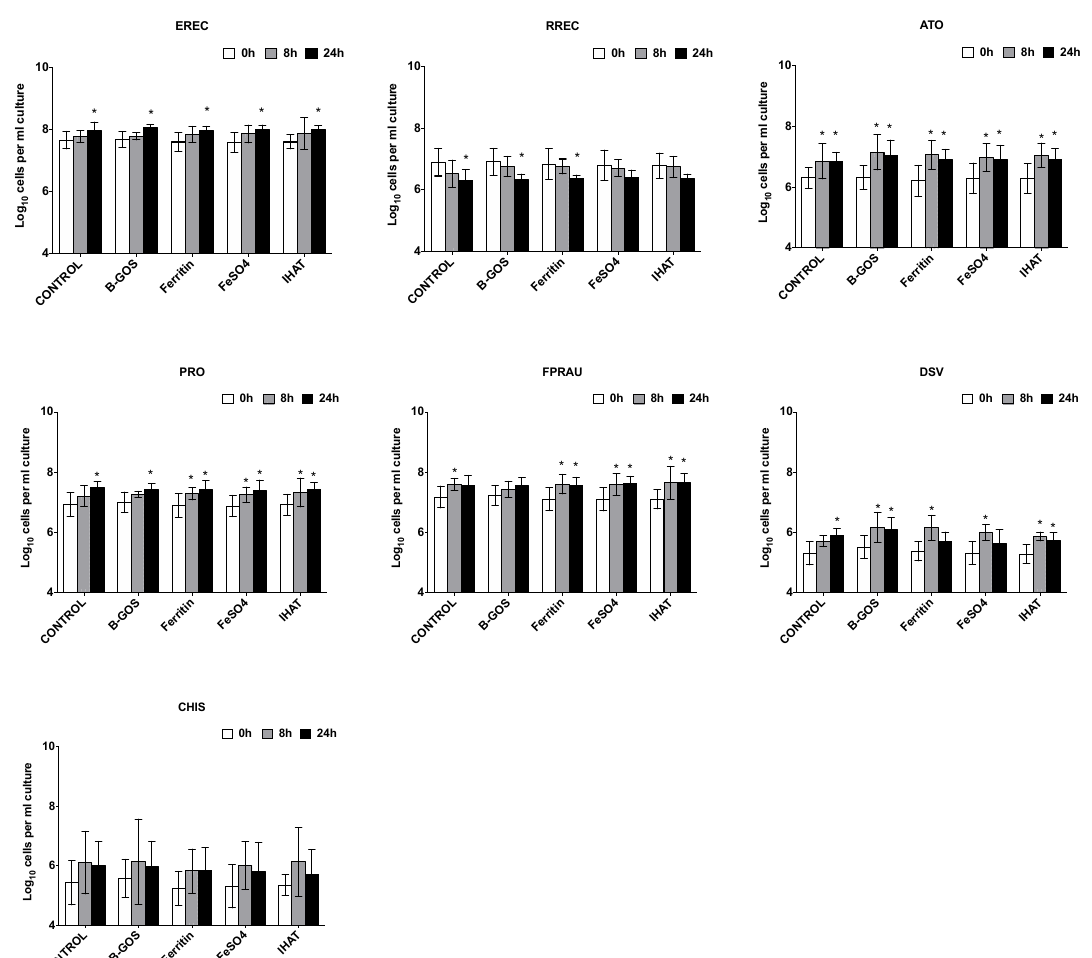
Figure 2. Effect of different substrates on bacterial groups detected by flow-FISH in pH-controlled batch cultures inoculated with faeces from healthy donors. Samples were collected at 0 h (baseline), 8 h and 24 h. Target bacteria: Bifidobacterium spp. (BIF), Lactobacillus spp. (LAB), most Bacteroidaceae and Prevotellaceae (BAC), Clostridium coccoides – Eubacterium rectale group (EREC), Roseburia subcluster (RREC), Faecalibacterium prausnitzii (FPRAU), Clostridium cluster IX (PRO), Atopobium – Coriobacterium spp. (ATO), Desulfovibrio (DSV) and Clostridium histolyticum (CHIS). Values are the mean from five independent experiments ± SD. Differences between substrates are indicated with p -values. *, significant differences from the baseline condition (i.e., time-point 0 h) for each substrate, p < 0.05.